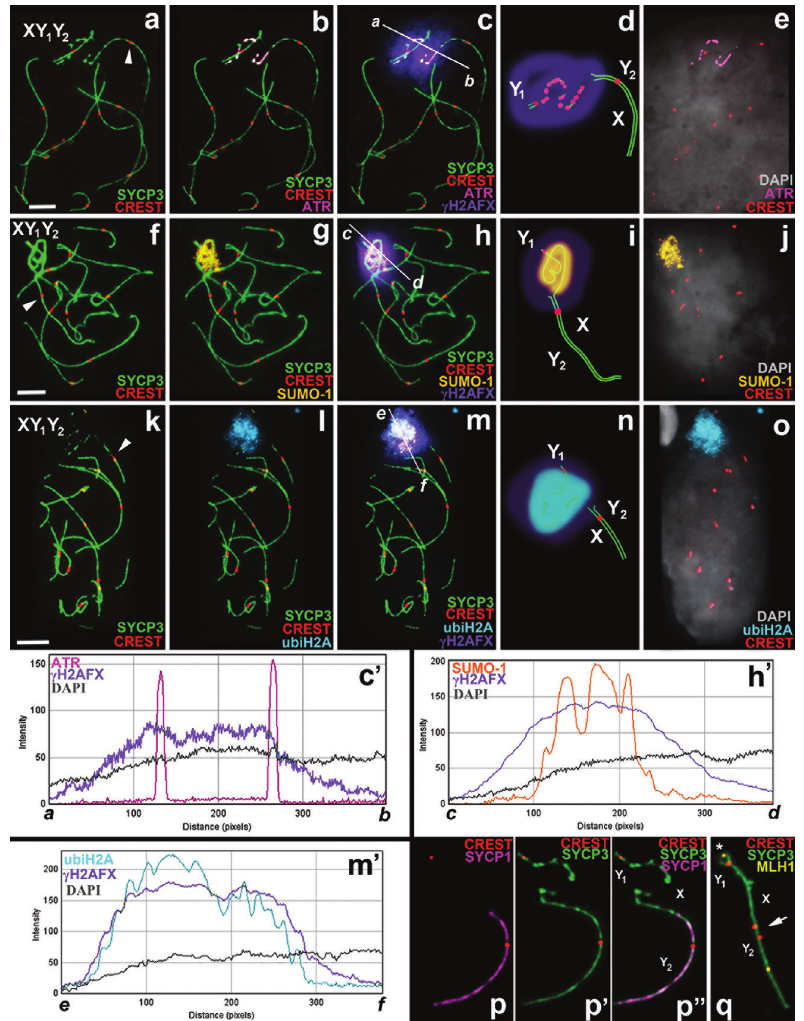
Figure 2. Mid-pachytene spermatocytes and male sex (XY 5µm. The axial elements of the SC and the kinetochores were localised using anti-SYCP3 ( green ) and anti-CREST ( red ) antibodies, respectively. a–e ATR ( magenta ) has a discontinuous localisation within the chromatin of the true sex chromosome regions (part of the X and the Y γ H2AFX ( violet ), DAPI ( grey ) is shown in graph a - b (see c and c’ ) f–j SUMO-1 ( yellow ) is localised on the chromatin of true sex chromosome regions. The co-localisation of SUMO-1, γ H2AFX ( violet ) and DAPI ( grey ) is shown in graph c - d (see h and h’ ) k–o ubiH2A ( cyan ) is localised on the chromatin of the true sex chromosome regions. The co-localisation of ubiH2A, γ H2AFX ( violet ) and DAPI ( grey ) is shown in graph e - f (see m and m’ ) d, i, n Diagrams of the sex trivalents p, p’, p’’ SYCP1 ( magenta ) is located on the area of chromosome synapsis of the autosomal part of the XY signals ( yellow ). The MLH1 signal within the PAR synaptic site is marked by an asterisk. The arrowhead indicates the centromeres of the autosomal part of sex trivalent (part of the X and the Y co-oriented with each other ( red